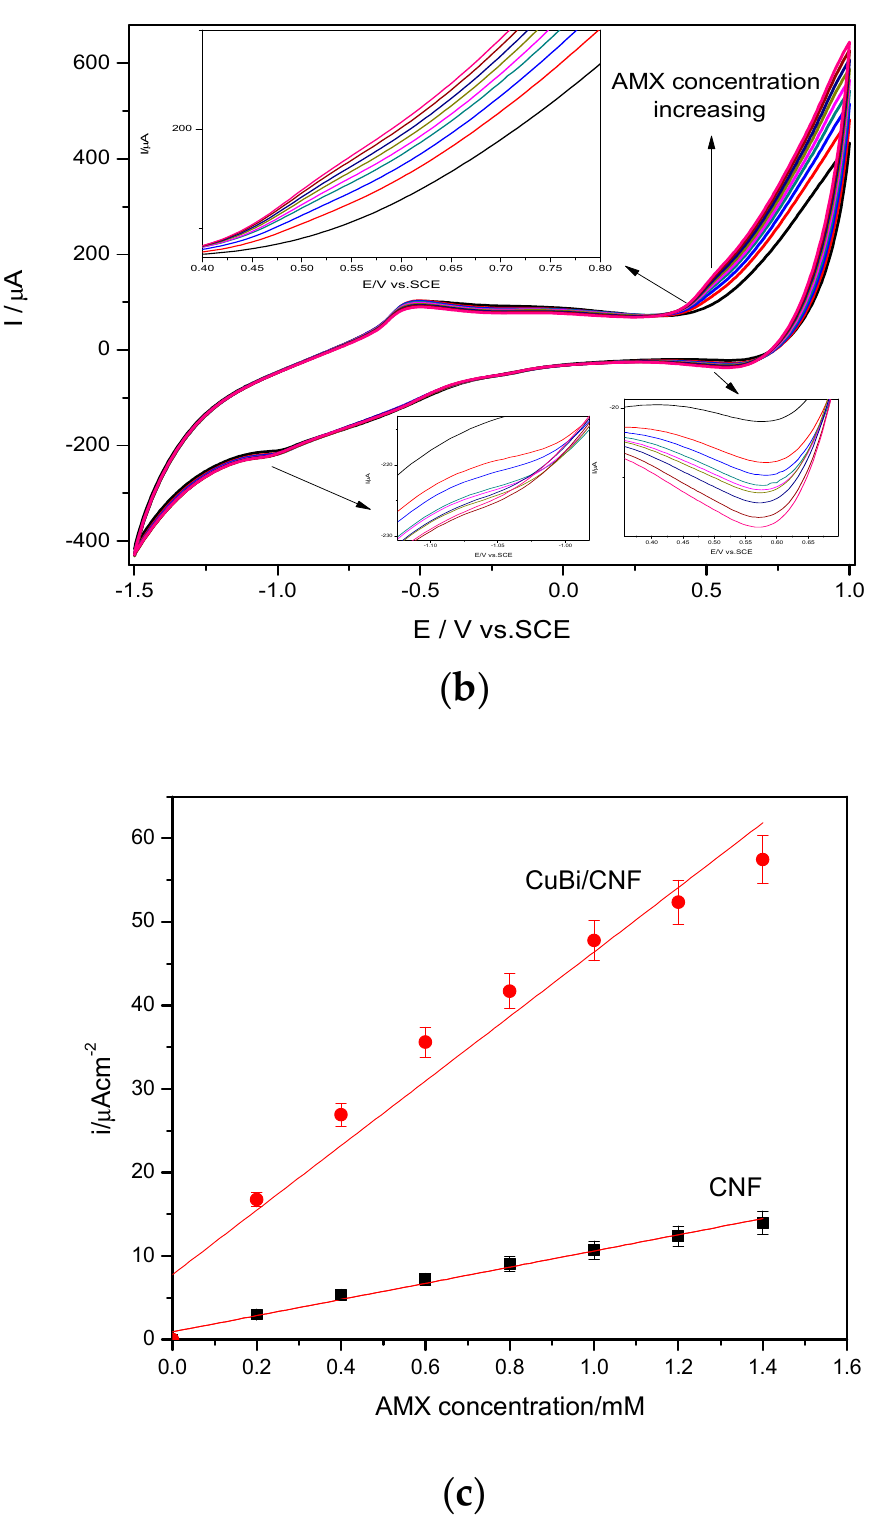
Figure 6. Cyclic voltammograms recorded at the 0.5 Vs − 1 scan rate on the CNF paste electrode ( a ) and CuBi/CNF modified paste electrode ( b ) in 0.1 M Na 2 SO 4 supporting electrolyte and in the presence of various AMX concentrations ranged from 0.2 mM to 1.6 mM AMX concentration. Comparative calibration plots for AMX detection in the concentration range from 0.2 to 1.4 mM, rerecorded at the potential value of +0.55 V/SCE ( c